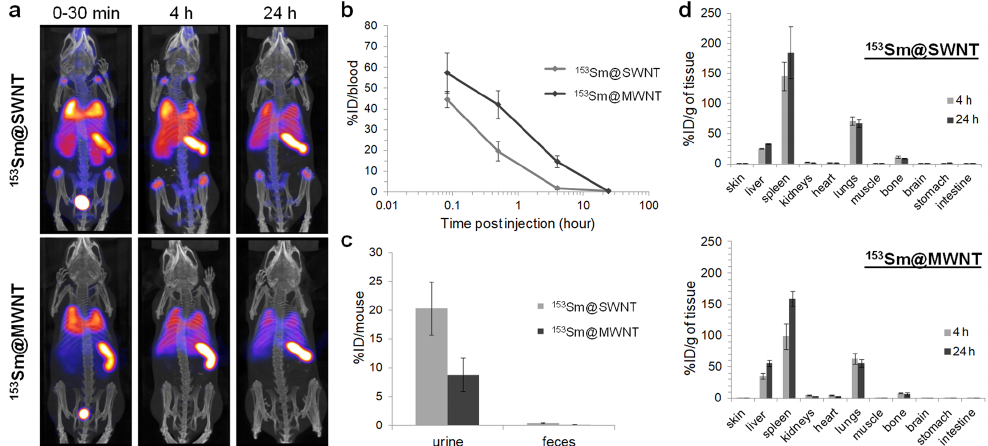
Figure 4. Whole-body SPECT/CT imaging and quantitative γ -counting that were used to study the pharmacokinetics and biodistribution of 153 Sm@SWCNTs and 153 Sm@MWCNTs up to 24 h. ( a ) SPECT/CT imaging, ( b ) blood circulation, ( c ) excretion profiles, and ( d ) tissue biodistribution profiles. Reprinted with permission from [111]. Copyright 2020, American Chemical